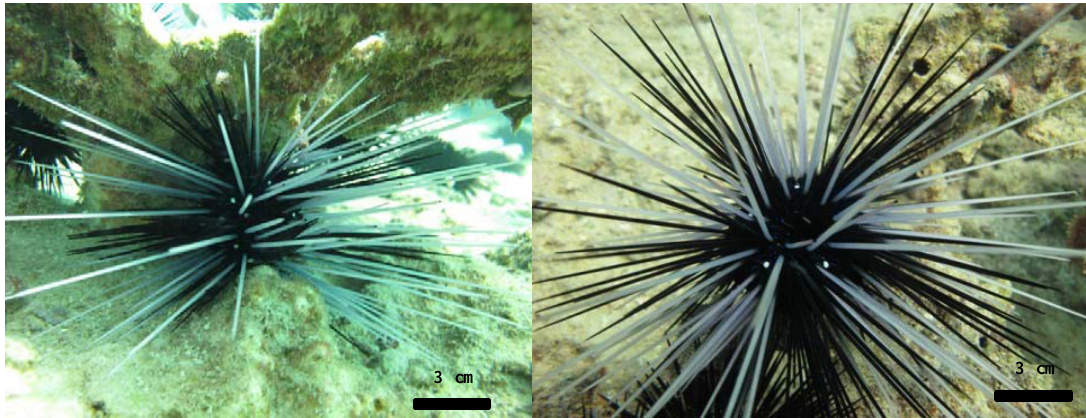
F IGURE 8. Diadema savignyi (Audouin, 1829)